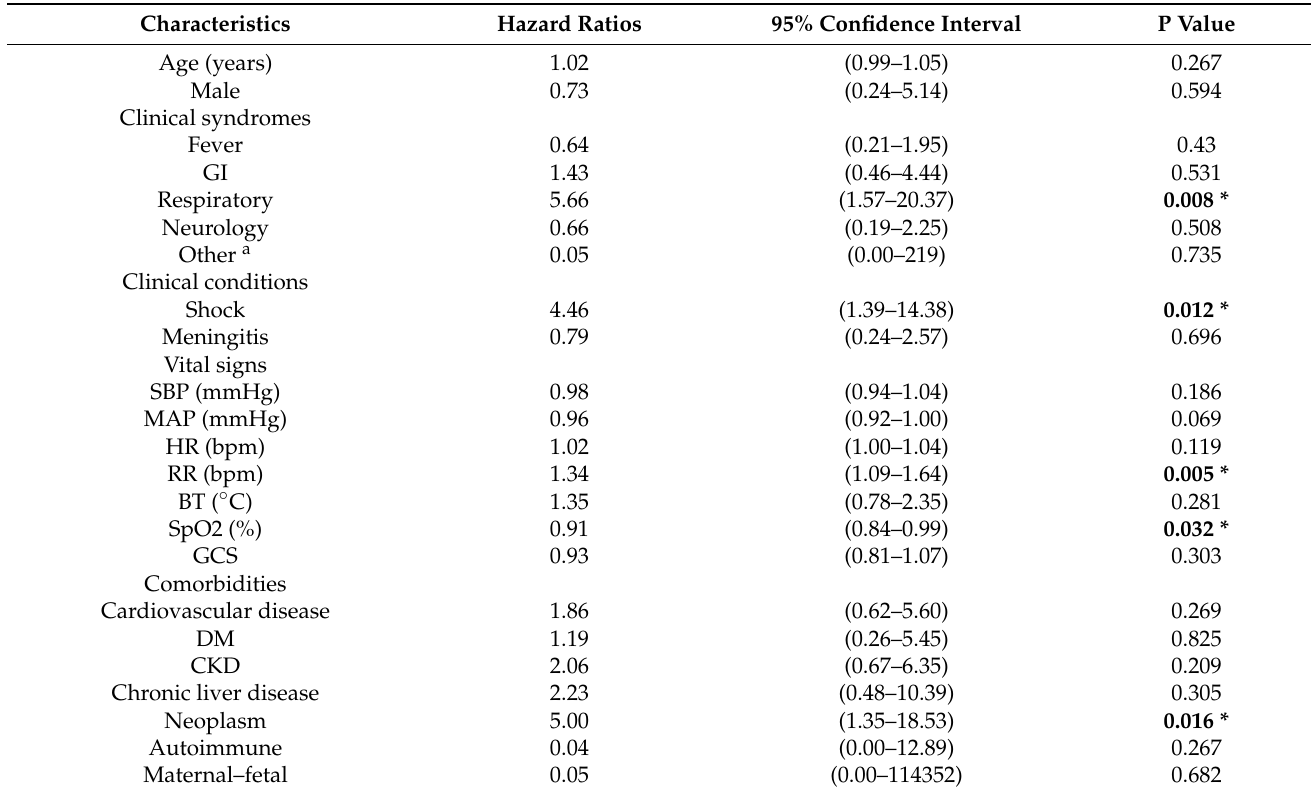
Table 2. Results of univariate analyses for predisposing factors on clinical outcomes in patients of Listeria monocytogenes